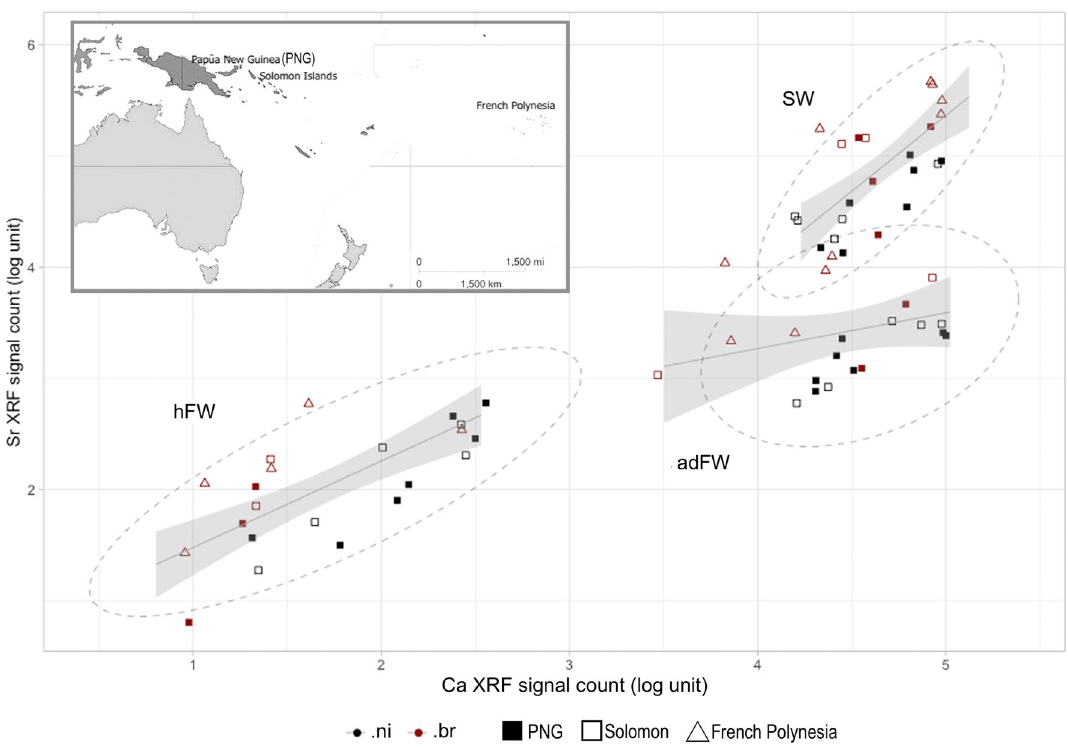
Figure 3. Distribution of strontium (Sr) as a function of calcium (Ca) element between each area ( hatching freshwater (hFW), sea water (SW) and adult freshwater (adFW)) with a map location of the sampling (top inset). Besides, a continuum can be drawn from the early post hatching group (hFW) to the otolith edge group (adFW) which stands for sustained Sr-Ca relationship correlated with individual growth, a discrete cluster (SW) signing for environment transition step. (.ni): Microphis nicoleae ; (.br): Microphis brachyurus ; PNG: Papua New